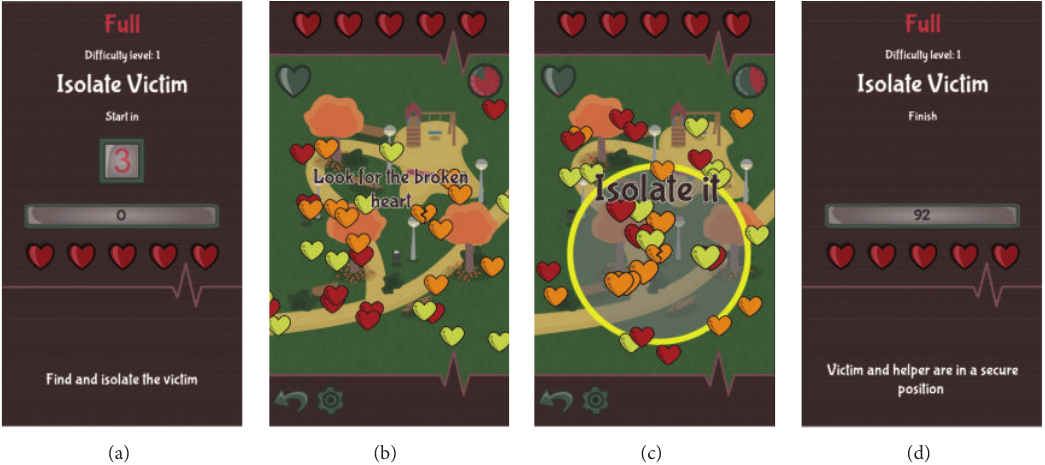
Figure 4: Screens of the Isolate Victim mini game. (a) Init screen with game instructions. (b) Before detecting the broken heart. (c) After detection of victim with the security perimeter from which hearts have to be removed. (d) Final screen where we can see the game score and the message that victim and helper are in a secure position.